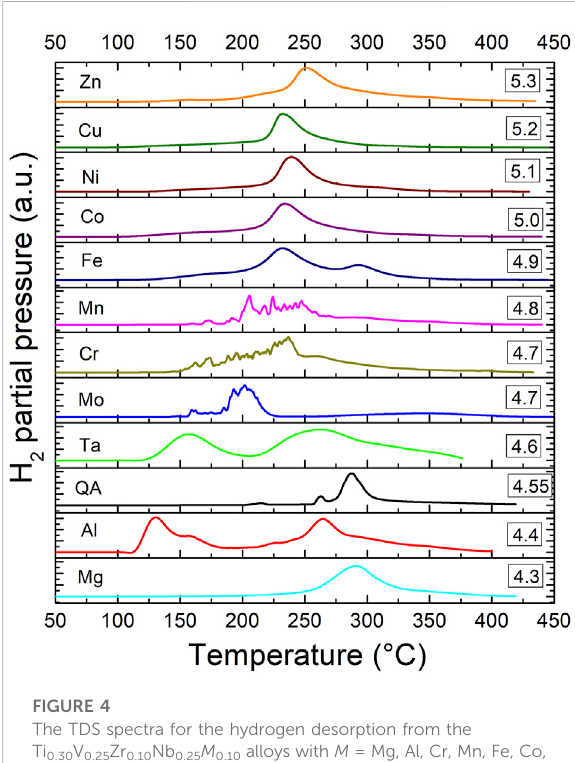
spectra are stacked as function of increasing